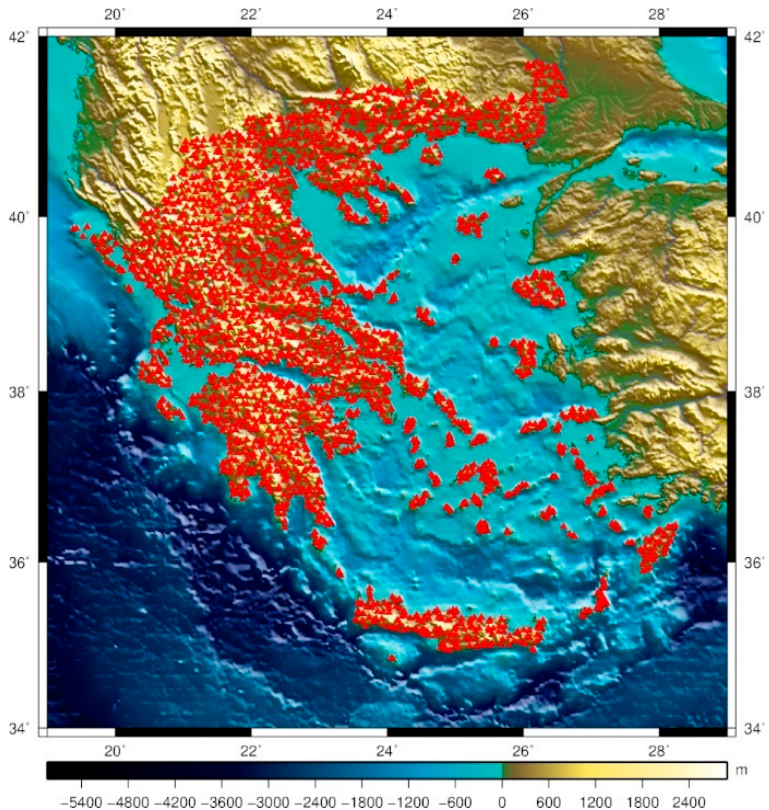
Figure 12. Geographical distribution of the 2431 GNSS/levelling benchmarks over Greece.